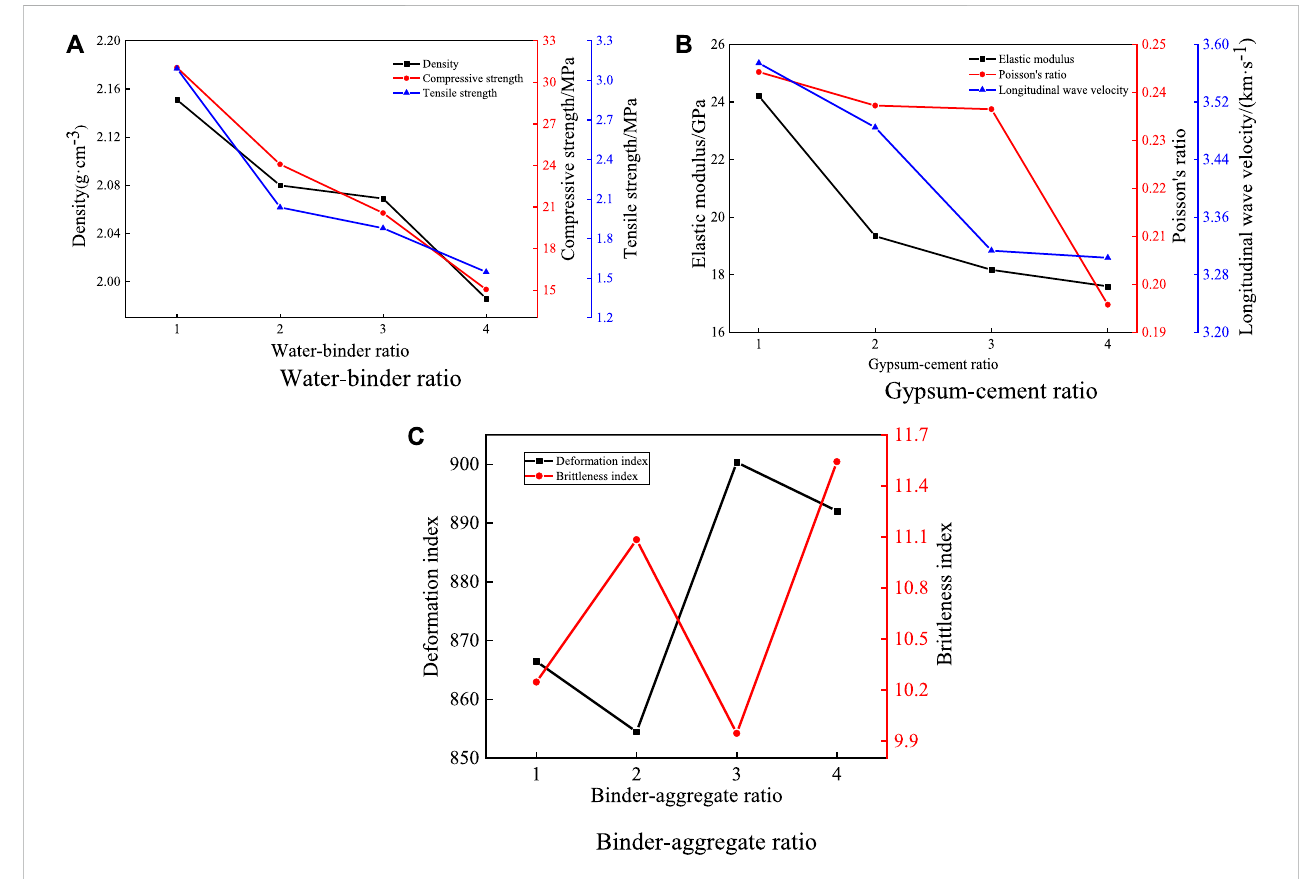
FIGURE 12 Comparative analysis of three factors and physical mechanical properties. (A) Water-binder ratio (B) Gypsum-cement ratio (C) Binder-aggregate ratio.